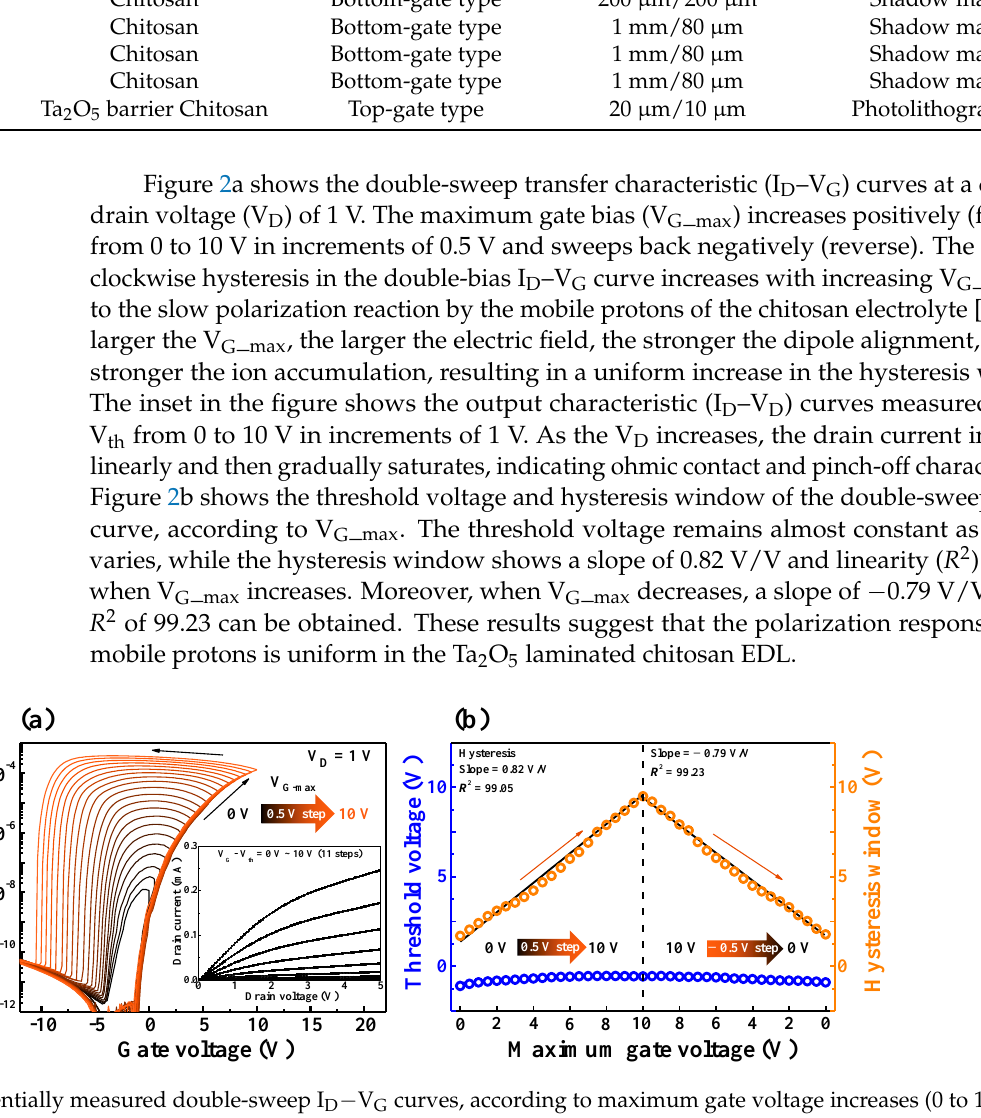
Figure 2. ( a ) Sequentially measured double-sweep I D − V G curves, according to maximum gate voltage increases (0 to 10 V in 0.5 V increments); the inset shows the I D − V D curves. ( b ) Threshold voltage and hysteresis window variation extracted from double sweep I D − V G curves, according to maximum gate voltage increased and then decreased.